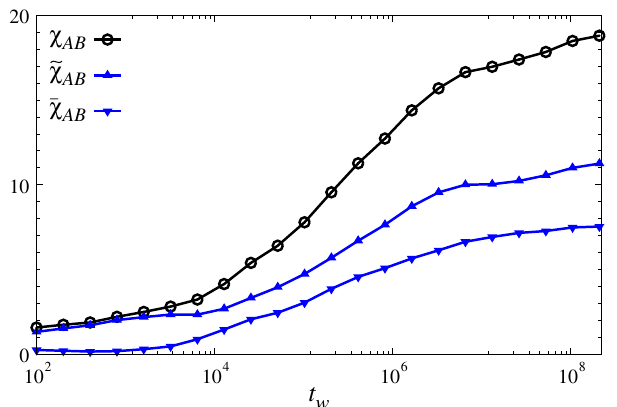
FIG. 5. Time evolution of the susceptibilities at Z ¼ 1000 . The total susceptibility χ is decomposed into sample-to-sample AB ð t Þ and clone-to-clone fluctuations within each fluctuations ¯ χ AB w ð t Þ . Both contributions are comparable in individual sample ˜ χ AB w amplitude and time